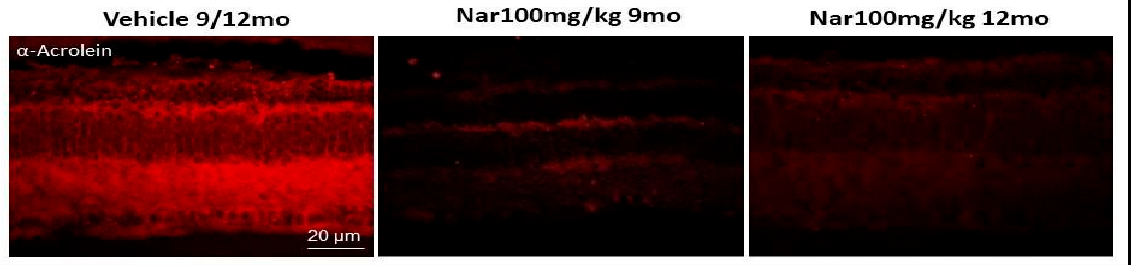
Figure 9. Naringenin reduces lipid peroxidation levels in older C57BL/6J mice. The figure shows the retinal section ob- tained from animal treated with vehicle alone or with naringenin 100/mg/kg/day respectively for three or six months. Red staining was obtained with the antibody anti-acrolein.